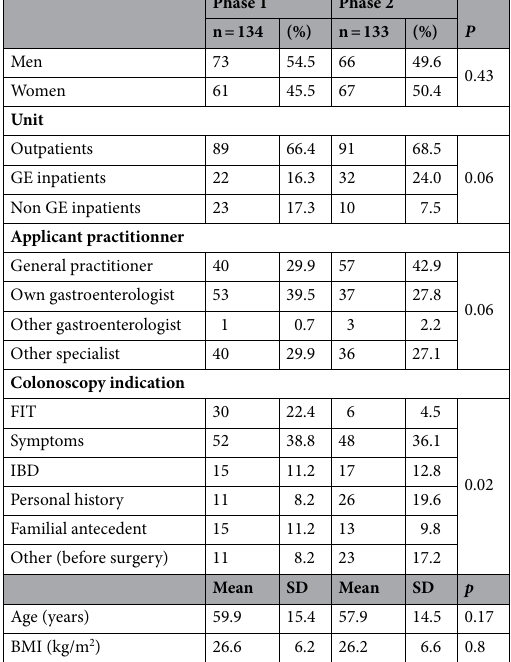
Table 1. Population characteristics. FIT: Fecal immunological test, IBD: inflammatory bowel disease, BMI: body mass index, SD: standard deviation, GE: